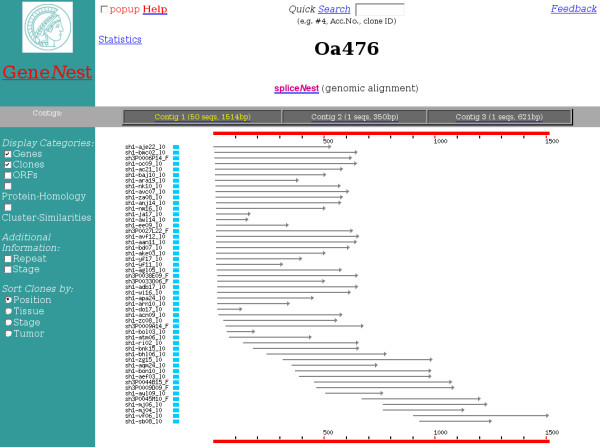
GeneNest Ovis aries gene index database. In this example, the data for integrin-binding sialoprotein (IBSP) are shown. A cluster based on three contigs, each of which can be individually displayed, corresponds to IBSP. EST sequences from which the contigs were constructed as well as their locations and libraries are displayed. A consensus sequence can be downloaded for each contig. Open-reading frames can be optionally displayed, and other options for data display are available [12]. The database is publicly available at .